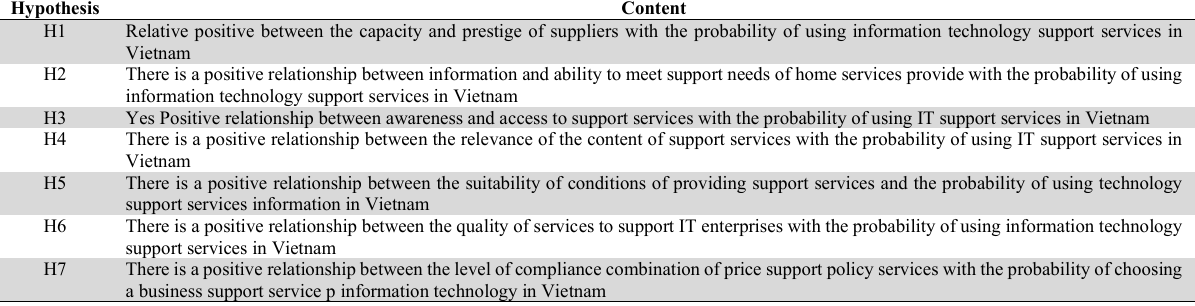
The hypothesis of the survey